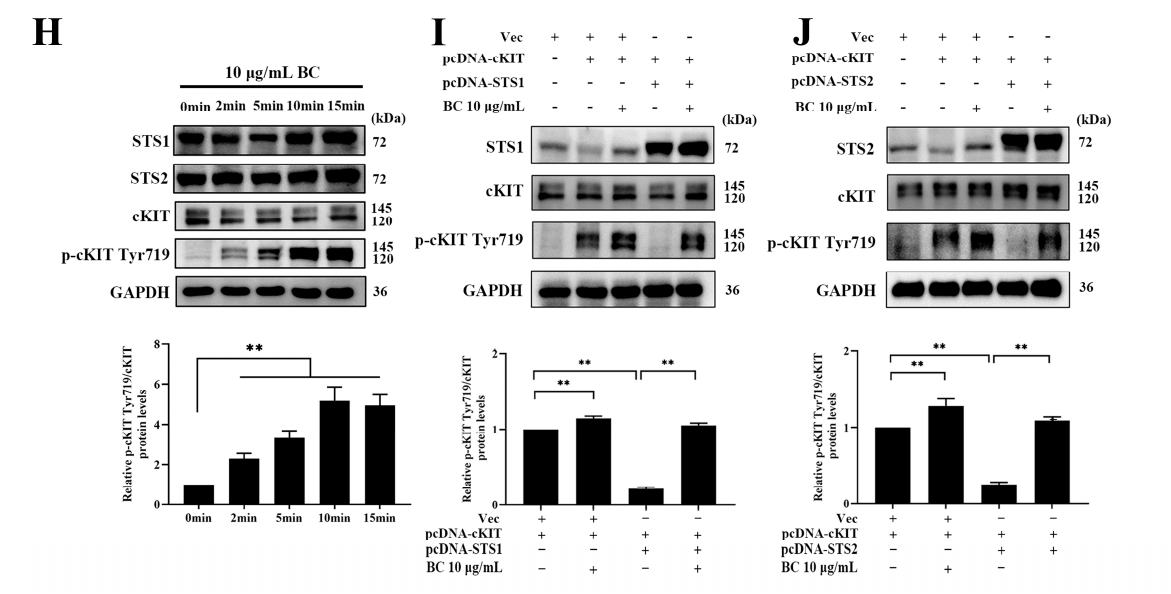
Figure 2. BC interacts with STS1 and STS2 HP domains and promotes phosphorylation of FLT3 and cKIT by inhibiting STS1 and STS2. ( A , B ) Molecular docking analysis of the binding of BC with STS1 ( A ) or STS2 ( B ). Left: The representative docking pose of BC with the HP domain STS1 (5VR6) or STS2 (5WDI). BC and the key residues of protein receptor are shown as sticks. The red dashed lines indicate the hydrogen bonds formed. Right: The 2D docked conformation showing the hydrophobic contacts (red eyelash shape) between BC and the HP domain of STS1 or STS2. ( C , D ) Capillary electrophoresis analysis of the binding of BC to STS1 ( C ) or STS2 ( D ). BC, STS1 or STS2 samples were prepared in 20 mM PBS at pH 7.0, and electrophoresis was run under 20 kV voltage. Red ( C ) or blue ( D ) arrows represent STS1 or STS2 protein peaks, respectively. ( E , H ) HEK293T cells were transiently transfected with FLT3 ( E ) or cKIT ( H ) constructs, and 48 h later, cells were stimulated with 10 µ g/mL BC for different periods of time at 37 ◦ C. Phosphorylated FLT3 (p − FLT3) or cKIT (p − cKIT) and endogenous STS1/STS2 proteins were detected by Western blot ( n = 3). GAPDH was used as internal control. ( F , G ) FLT3 construct was transfected into HEK293T cells together with or without pcDNA − STS1 ( F ) or − STS2 ( G ). Then, 48 h later, cells were stimulated with BC for 2 min at 37 ◦ C. The overexpressed proteins and phosphorylated FLT3 were detected by Western blot ( n = 3). Vec indicates empty vector control. ( I , J ) cKIT construct was transfected into HEK293T cells together with or without Flag − tagged STS1 ( I ) or STS2 ( J ). Then, 48 h later, cells were stimulated with BC for 2 min at 37 ◦ C. The overexpressed proteins and phosphorylated cKIT were detected by Western blot ( n = 3). Vec indicates empty vector control. All data are shown as mean ± SEM, ** p < 0.01 (Student’s t